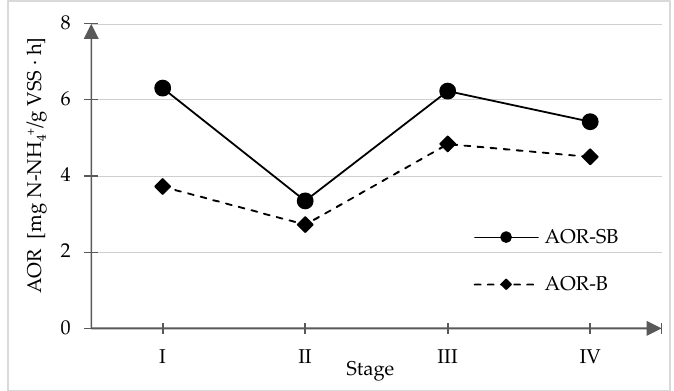
Figure 2. Ammonia oxidation rate for suspended biomass (AOR- SB) and biofilm (AOR-B).